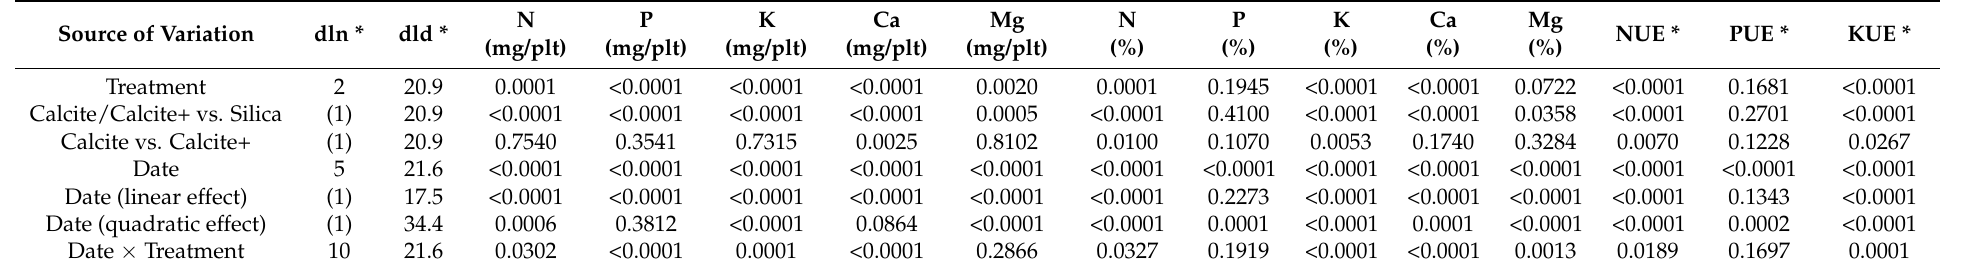
Table 6. Observed probabilities of fixed effects ( p values) associated with analysis of variance for the nutrient content (mg/plant), concentration (%) and nutrient use efficiency of roots of white spruce seedlings (1 +